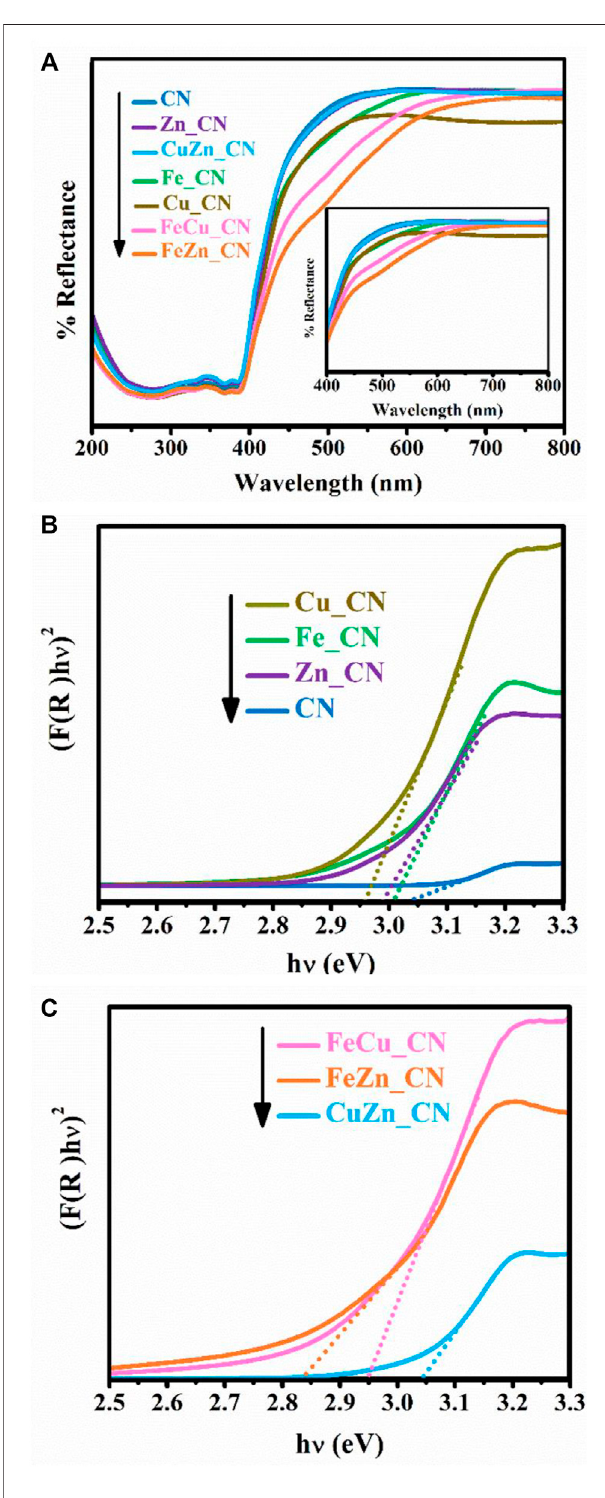
FIGURE 5 | (A) UV – Vis diffuse re fl ectance spectra and estimation of band-gap energies of undoped CN, (B) single-metal-doped CN, and (C) co- metal-doped CN